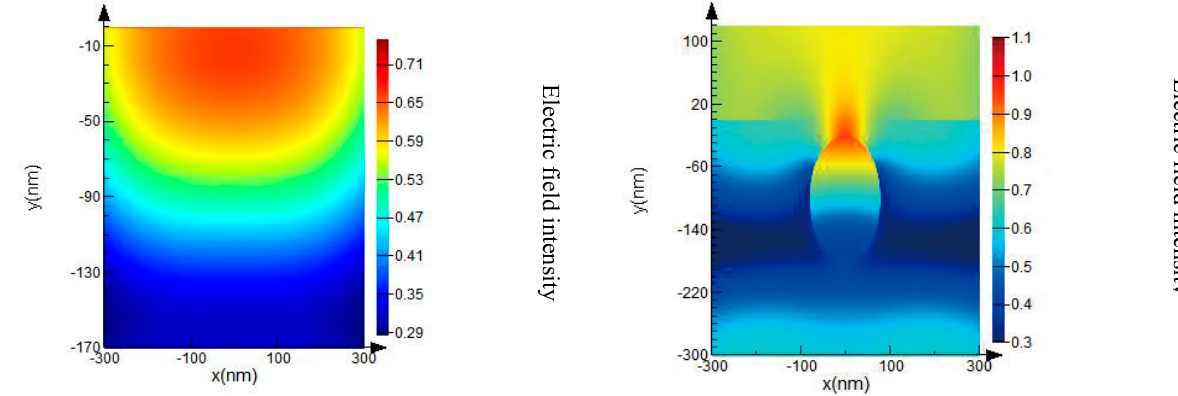
Figure 2. Light field distribution of films induced by the defect in the TiO 2 optical film. Figure 3 denotes the coupling effect of a defect and an organic contamination